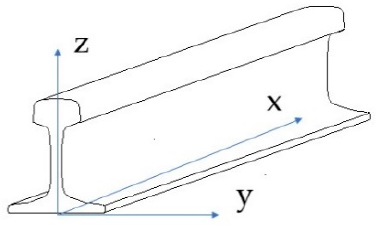
Figure 1. Coordinate system of a rail.